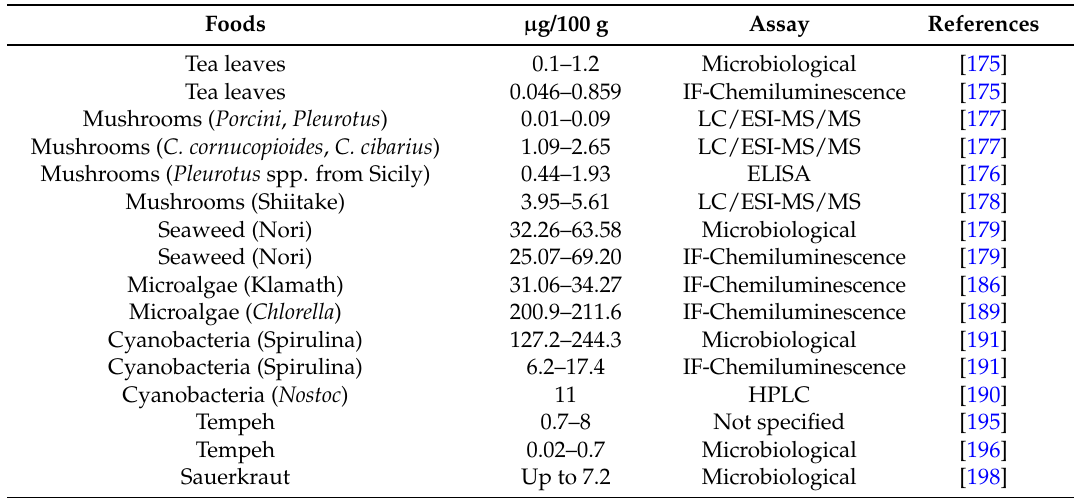
Table 5. Cobalamin content in vegetable